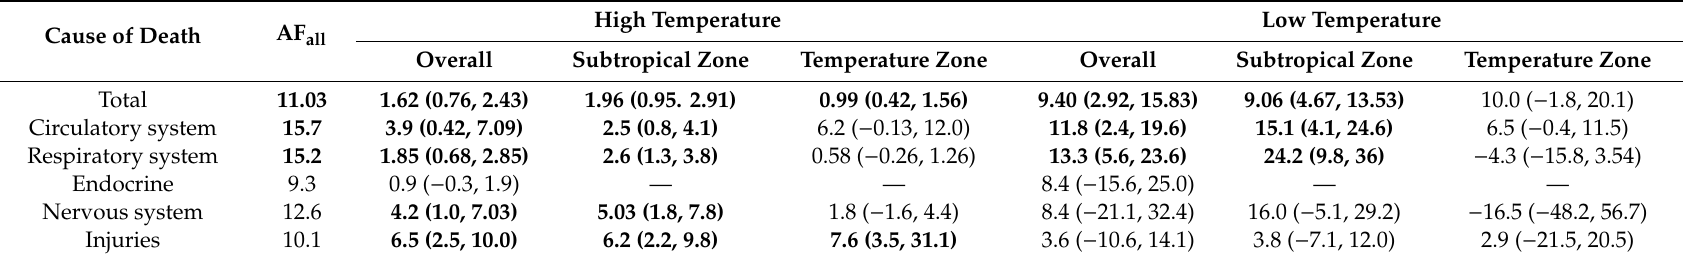
Table 4. Attributable fractions (%) of cause-specific mortality due to high and low temperatures in two regions in